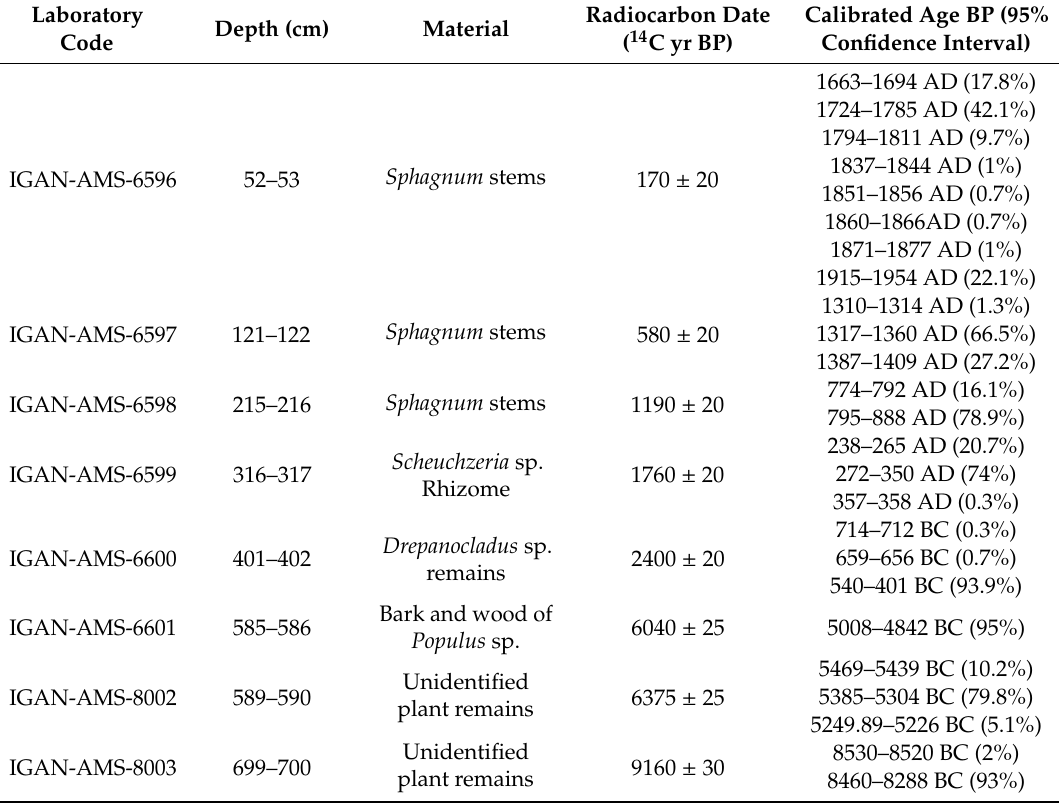
Table 1. Results of radiocarbon dating of the deposits in the Krivetskiy Mokh